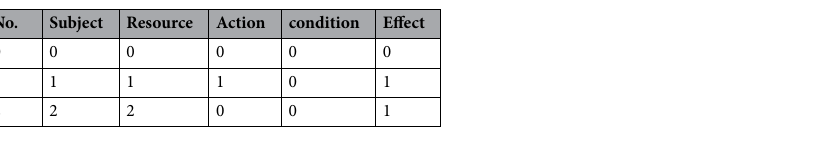
Table 1. A processed policy